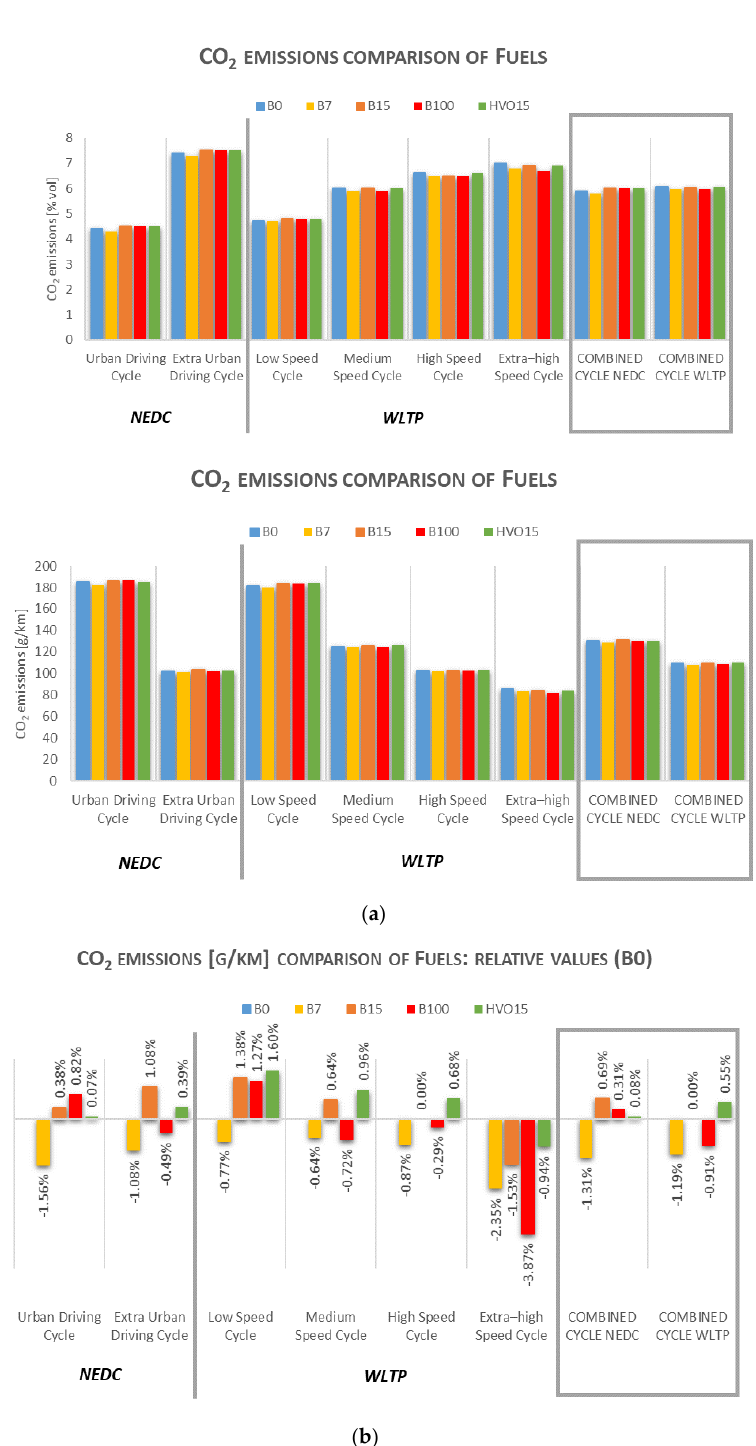
Figure 6. ( a ) CO 2 emissions comparison of fuels, in total value ((% vol) and (g/km)). ( b ) CO 2 emissions comparison of fuels, in percentage differences, in relation to the B0 fuel.